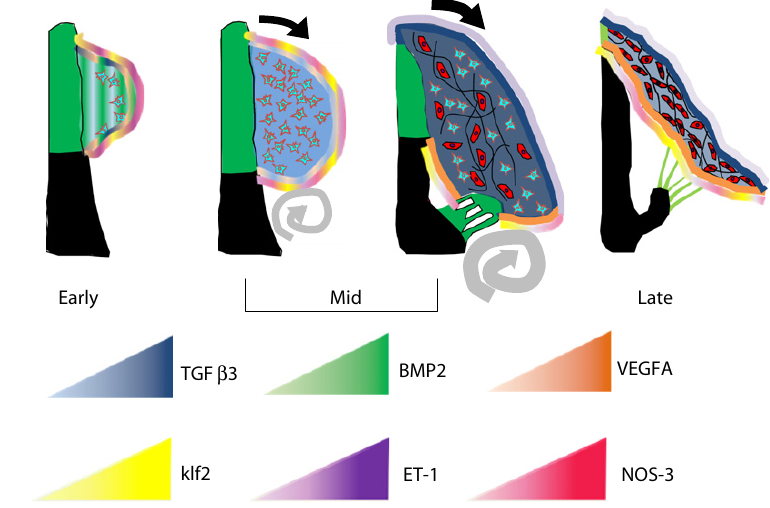
Figure. 5 Summary of flow and gene expression in early, late and mid valvular cusps. ET-1 is the only gene still expressed on both sides of the leaflet at late valvulogenesis. The increasing force of unidirectional flow in the atrial, inflow, surface corresponds with TGF β and ET-1 expression, while the increase in magnitude of retrograde flowvorticesontheventricularsidecorrespondswithVEGFA,NOS-3,KLF2,andET-1expression.BMPisrestricted to the boundary between the cushions and junctional myocardium. Black arrows indicate inflow, gray spiral retrograde flow vortices. Adapted from